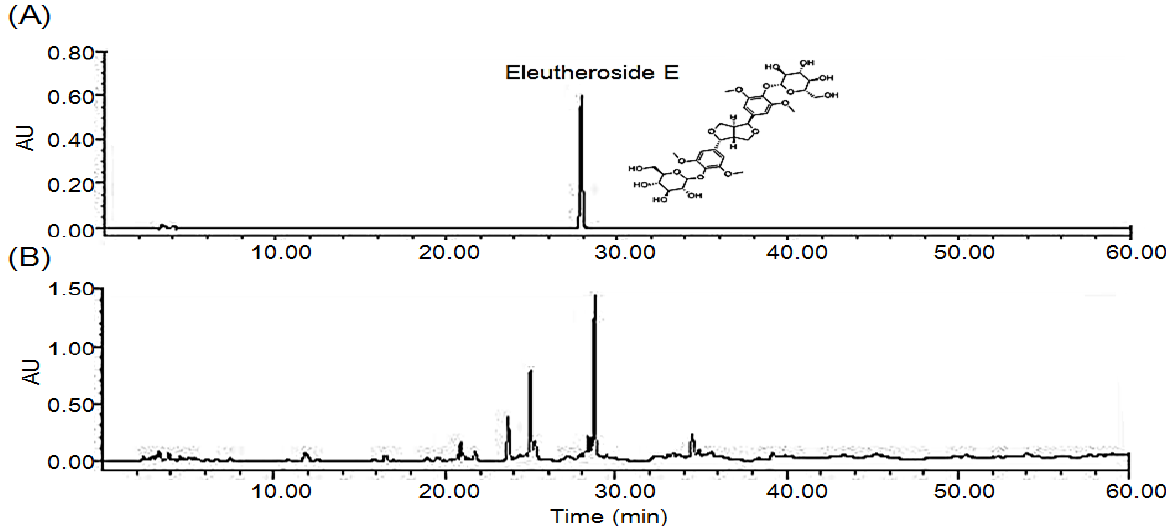
Figure 1. 2-D HPLC chromatograms of eleutheroside E ( A ) and DES ( B ). Detection was performed by using a photodiode array detector at 205 nm. X-axis is retention time (min); Y-axis is absorbance unit